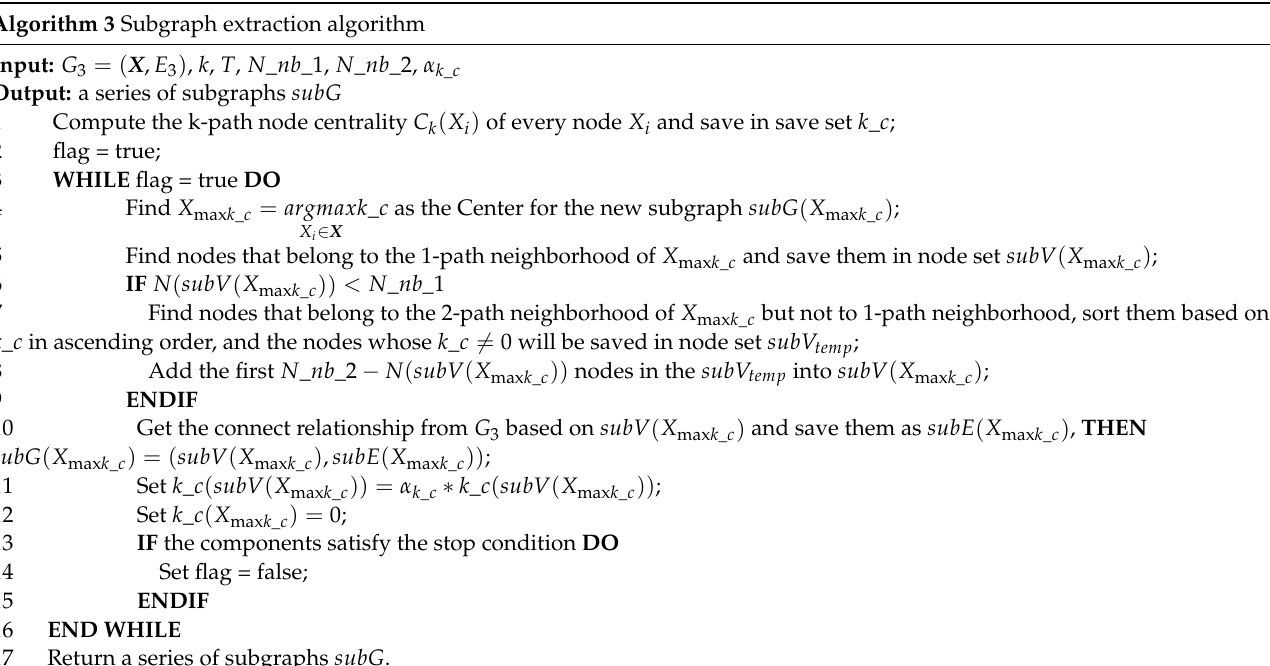
Algorithm 3 Subgraph extraction